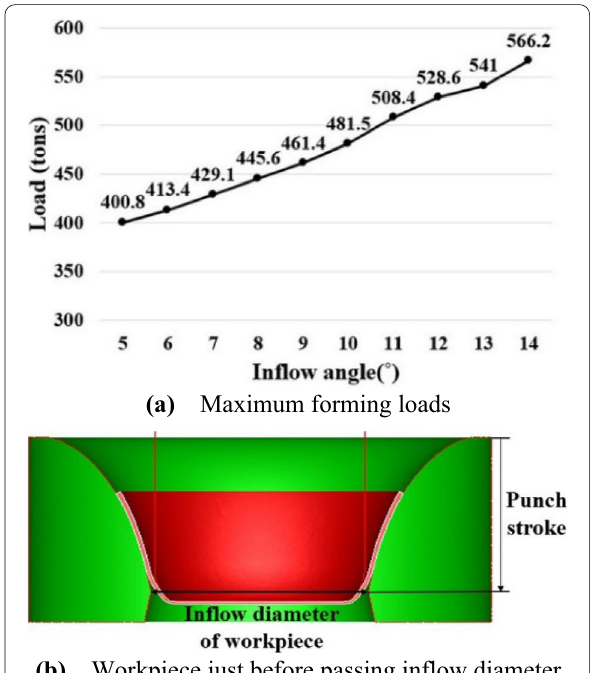
(b) Workpiece just before passing inflow diameter